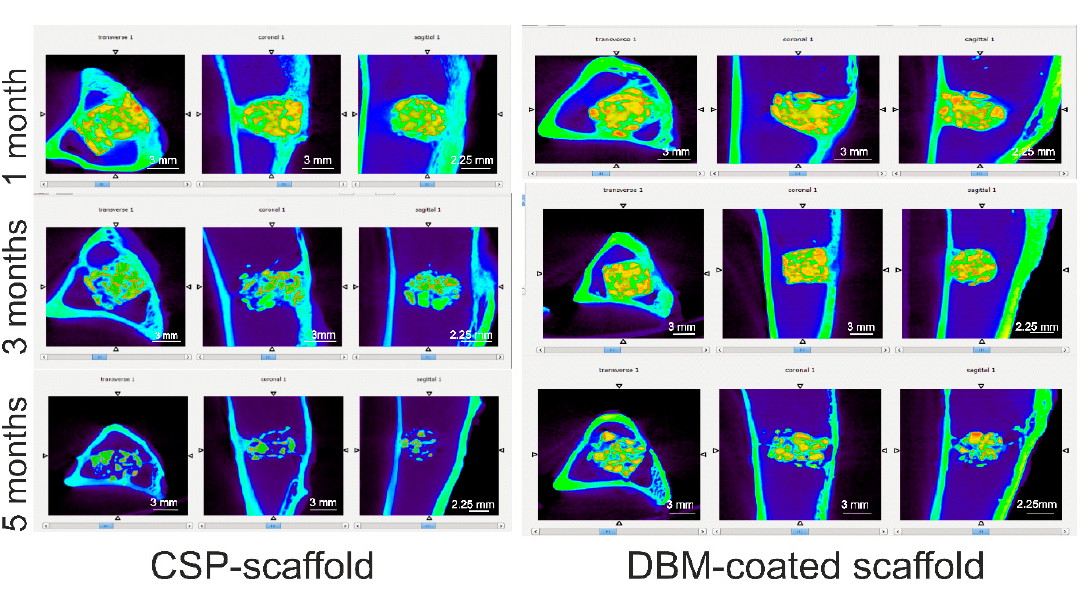
Figure 8. The micro-CT images of both materials implanted in tibiae at 1, 3, and 5 months post-surgery. Orange color corresponds to residual biomaterial. Yellow color corresponds to biomaterial partially reabsorbed. Green color corresponds to the cortical bone and represents the normal cortex of the host bone. Green color located within the biomaterial represents the reabsorbed biomaterial and new bone tissue. Blue color corresponds normal medullary tissue of the host bone. Blue color located within the biomaterial represents neoformed fibrous connective tissue.